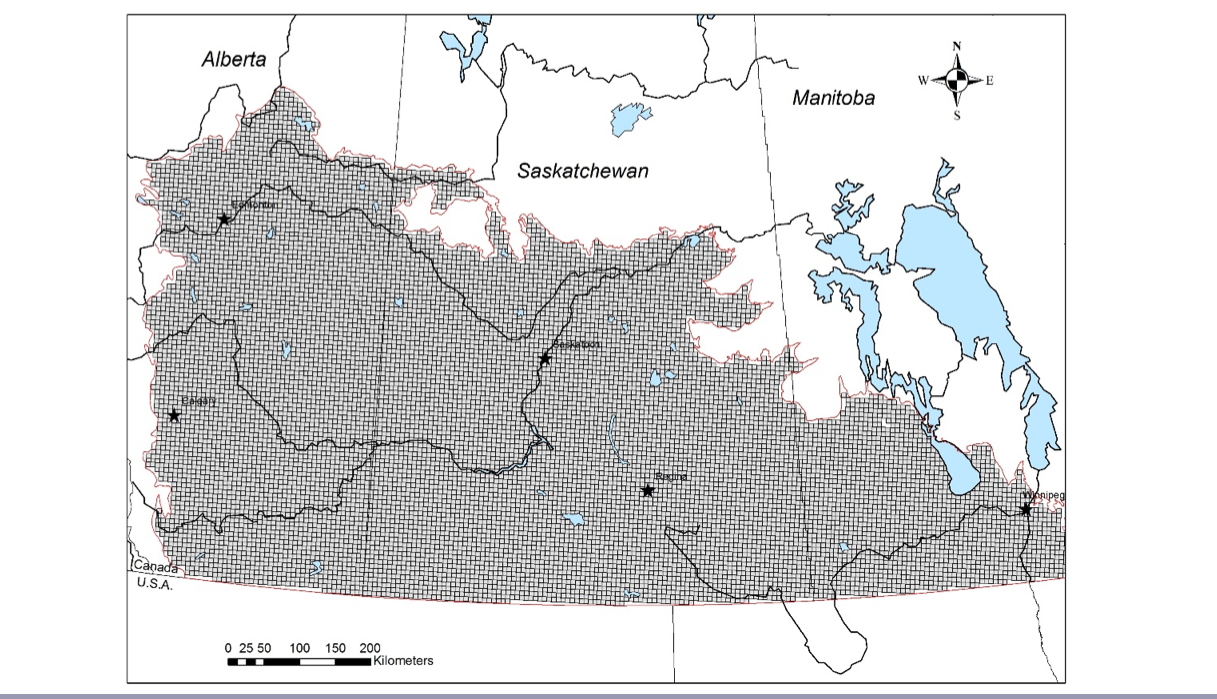
Fig. 2 . Network of 41-km² grids (n = 13,285) used in ArcGIS to extract estimated Northern Pintail ( Anas acuta ) breeding pairs, and habitat availability, for input into a productivity model that estimated the number of pintail nests initiated in spring-seeded